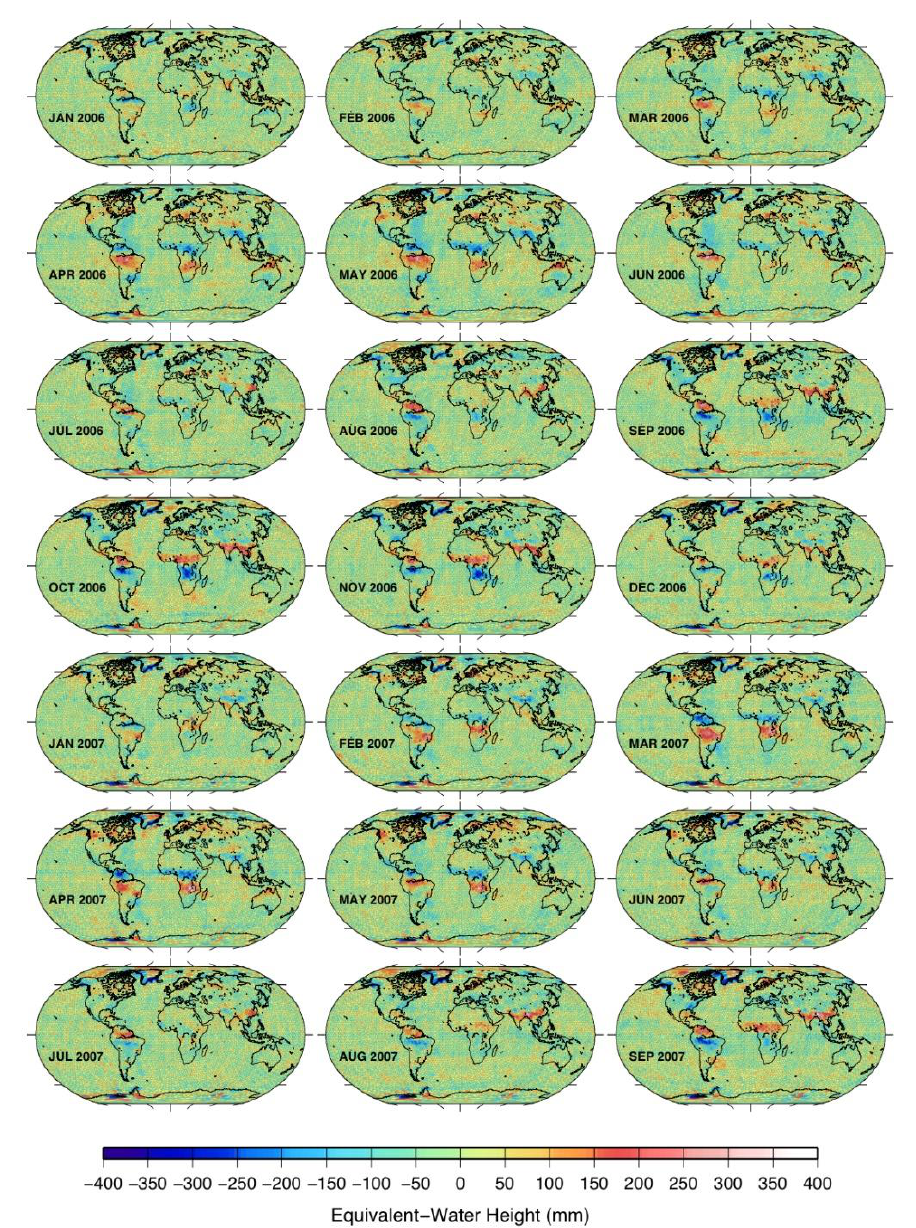
Figure 2. Daily global KF solutions computed by progressive integration of real GRACE potential differences and showing the evolution of the surface water mass density versus time.